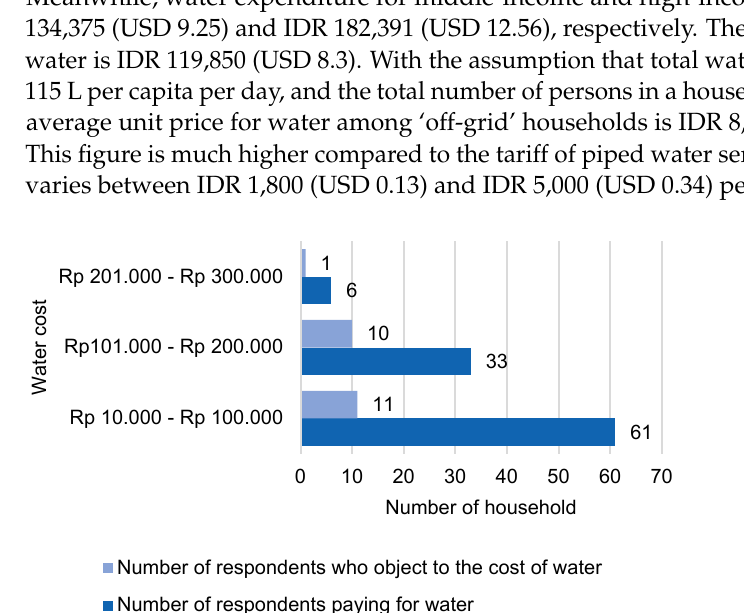
Figure 5. Public opinion regarding water affordability. The dark blue represents respondents who pay for water within a certain range, while the light blue represents respondents who feel they pay too much for water.